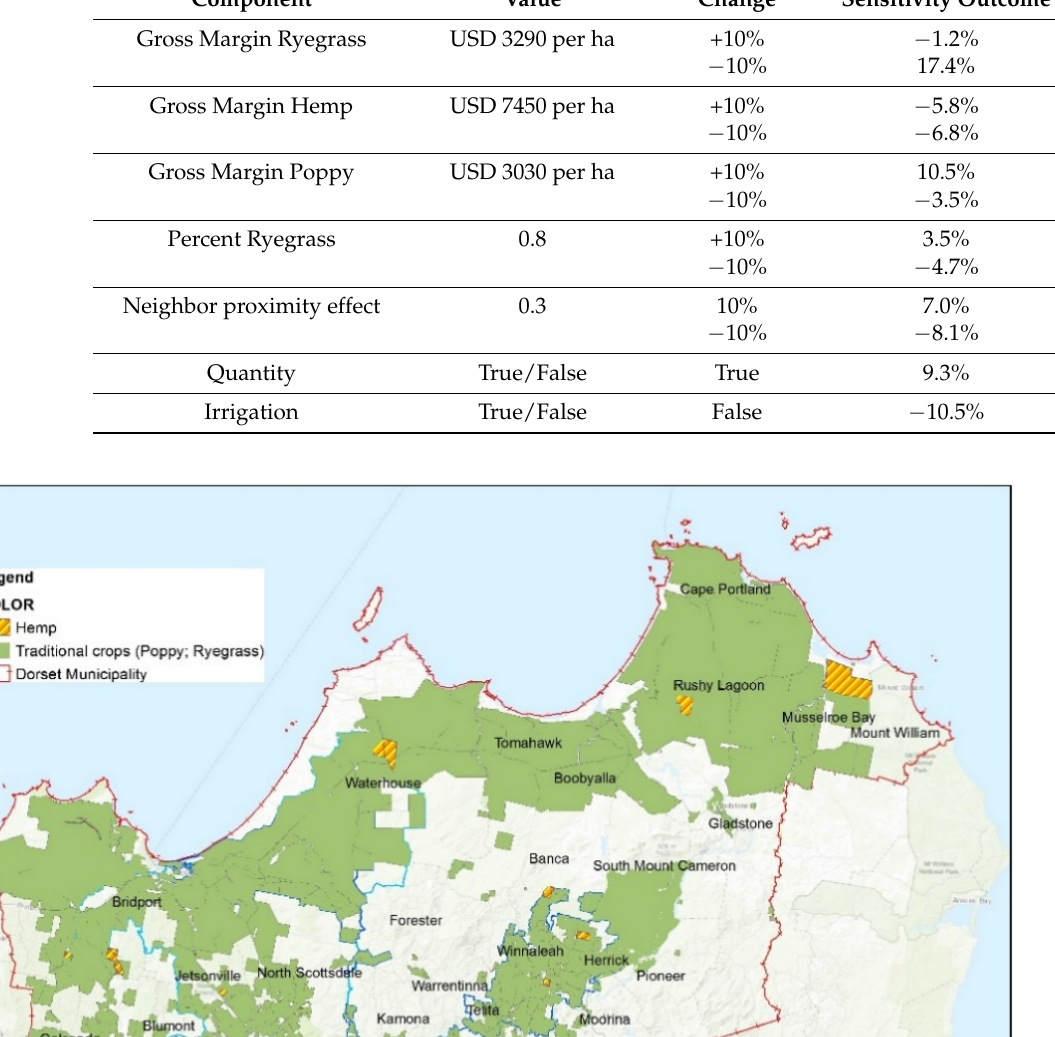
Figure 8. Distribution of hemp crops after 10 years for the Dorset region for the default scenario as irrigation infrastructure became available.